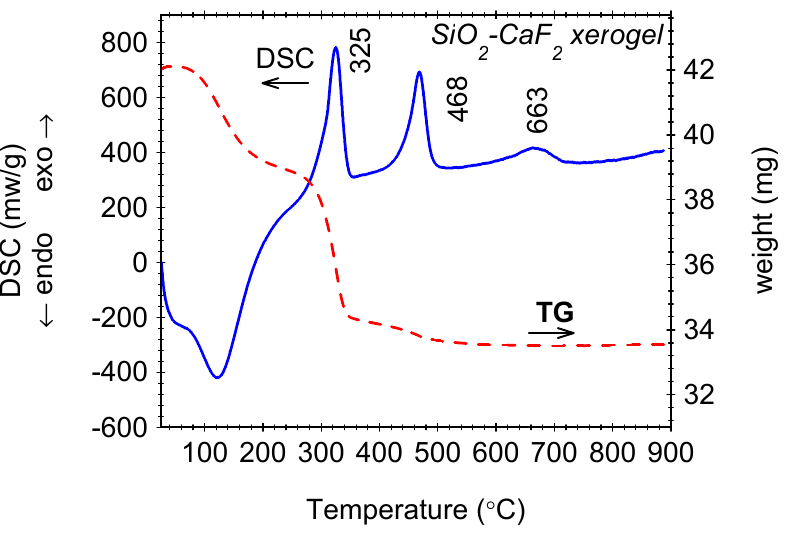
Figure 1. Thermal analysis results obtained on SiO 2 –CaF 2 xerogel.